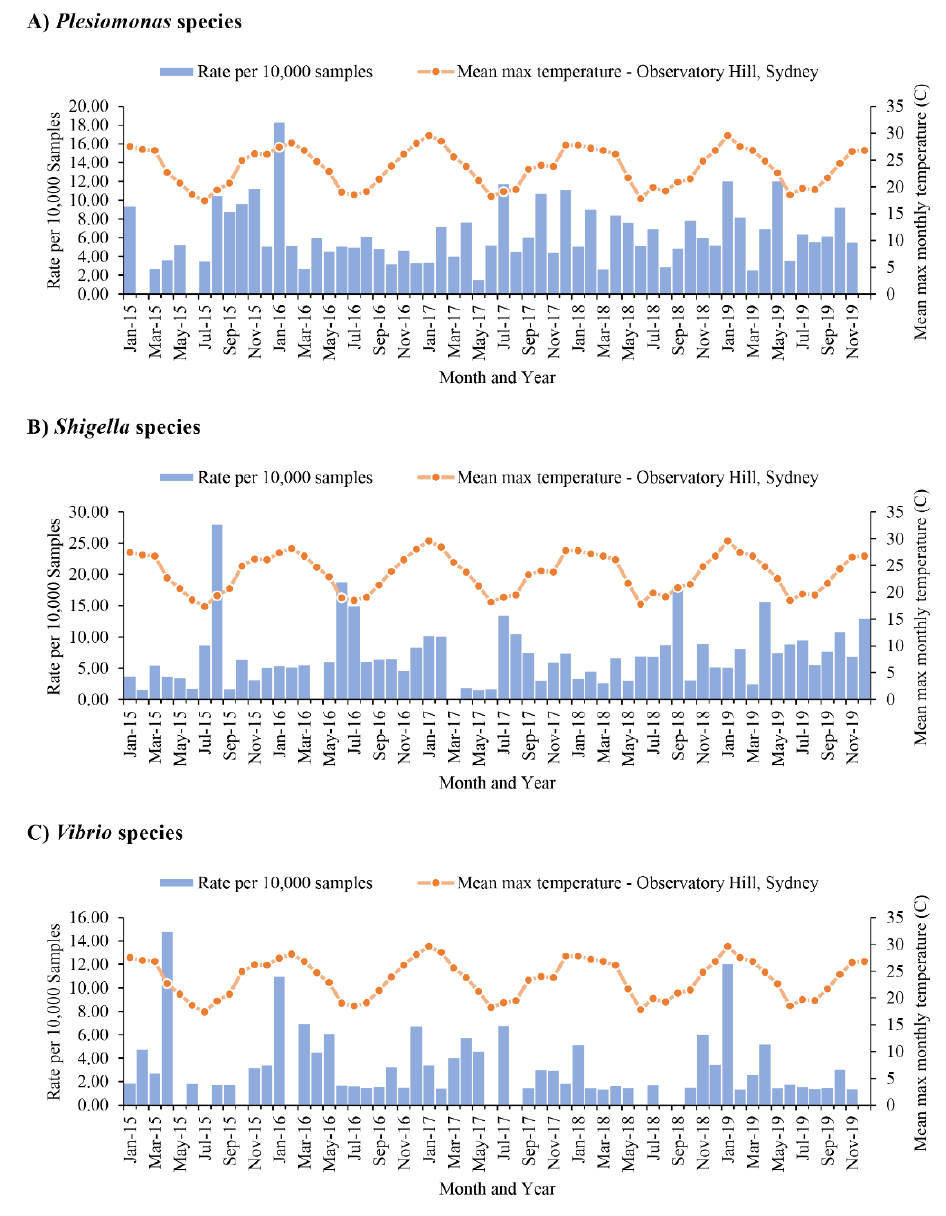
Figure 4. Isolation of Plesiomonas shigelloides , Shigella species and Vibrio species in individual month during 2015–2019. The bacterial pathogens were isolated from faecal samples of patients with gastroenteritis. The isolation rates were the positive isolations per 10,000 samples. The mean maximum temperature was from Observatory Hill, Sydney. ( A ) P. shigelloides , ( B ) Shigella species and ( C ) Vibrio species. There were no significant associations between the isolations of P. shigelloides and Shigella species with temperature. The isolation of Vibrio species was positively associated with temperature ( p = 0.013).